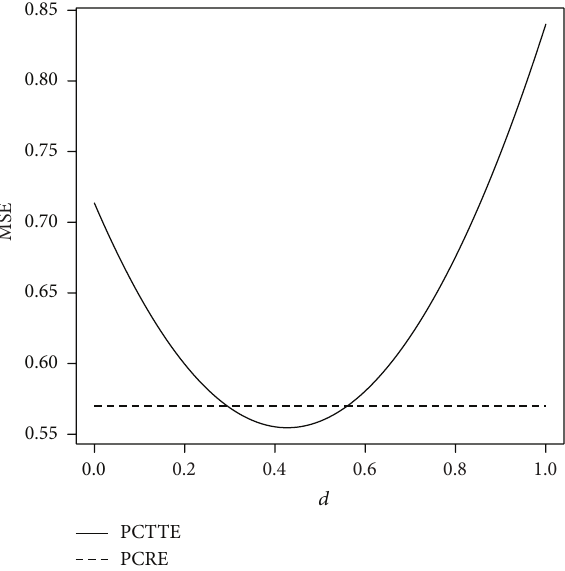
Figure 2: The MSE values of OLSE and PCTTE when 𝑘 = 0.56 .